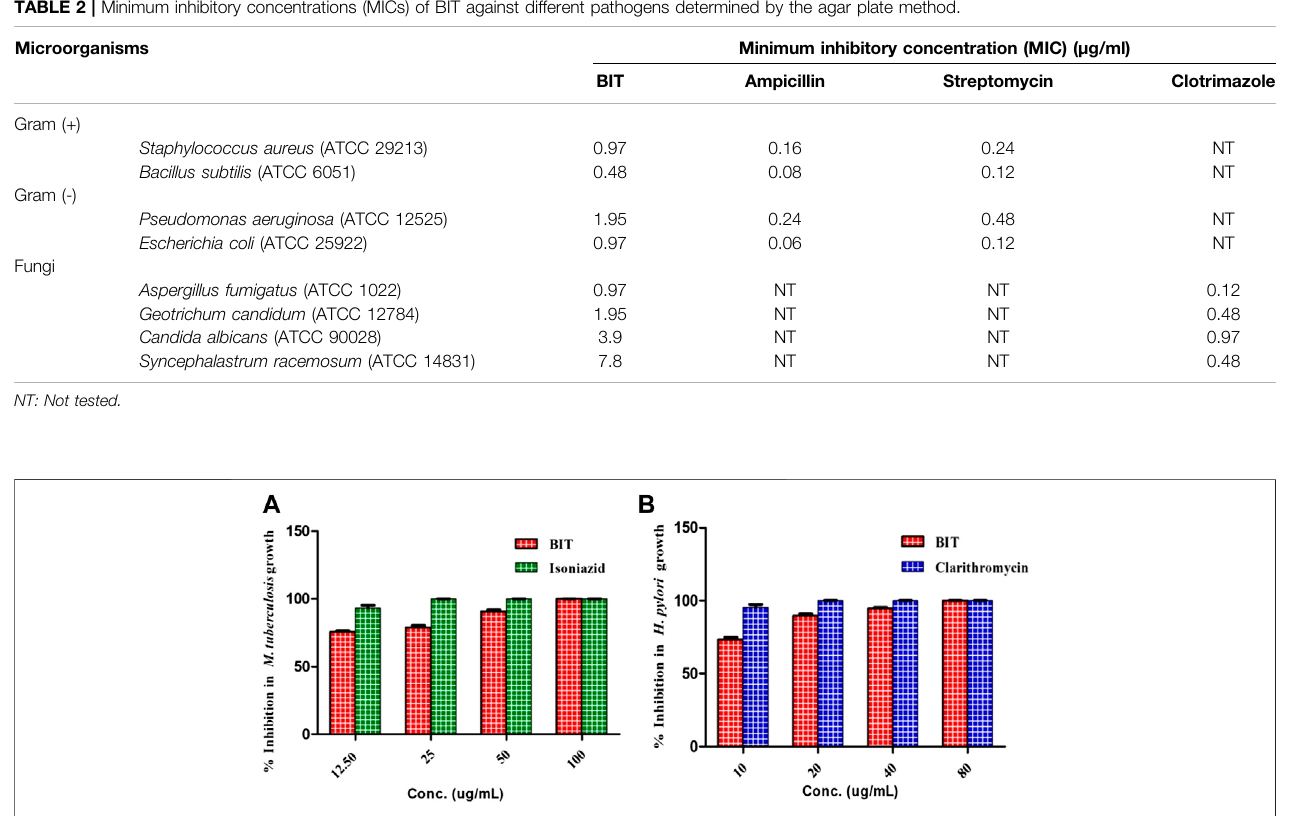
FIGURE 2 | Effect of BIT and isoniazid different concentrations on the M. tuberculosis (A) and effect of different BIT concentrations and clarithromycin on H. pylori growth (B) .